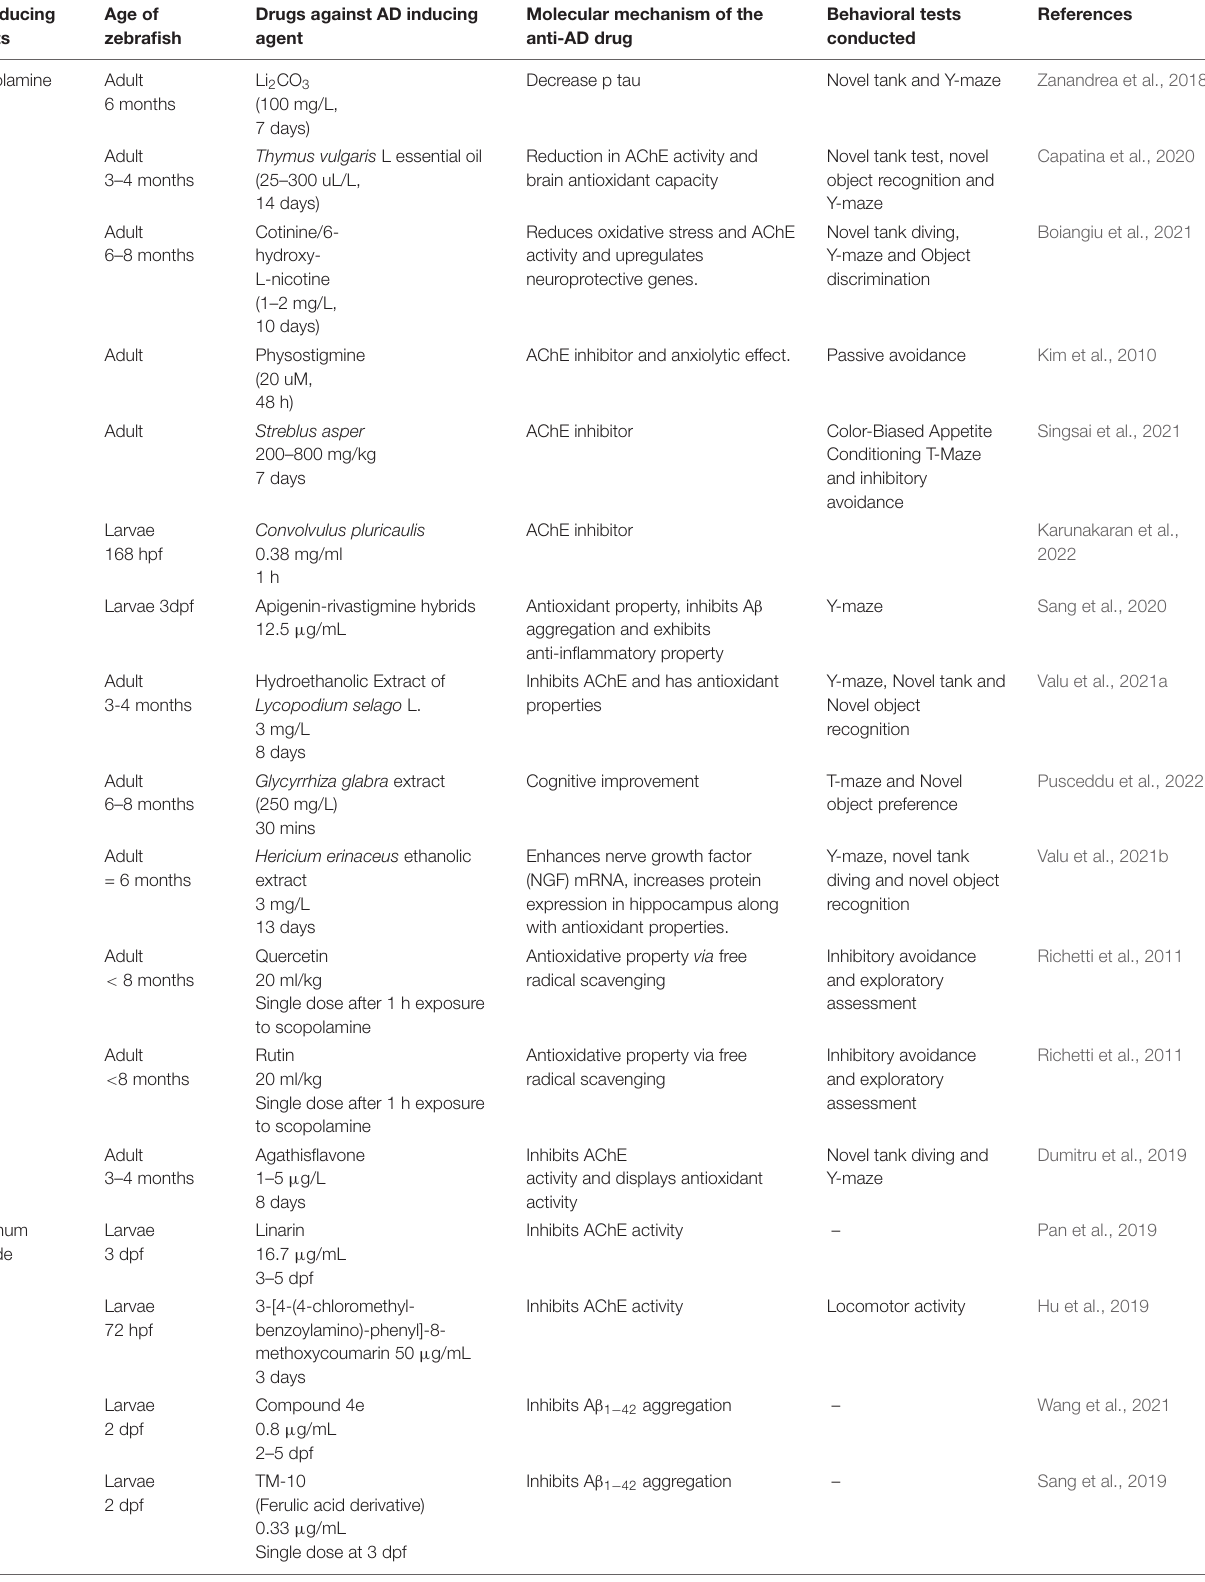
TABLE 3 | Table for zebrafish pathways, models, and drugs that affect those pathways. AD Inducing Age of agents